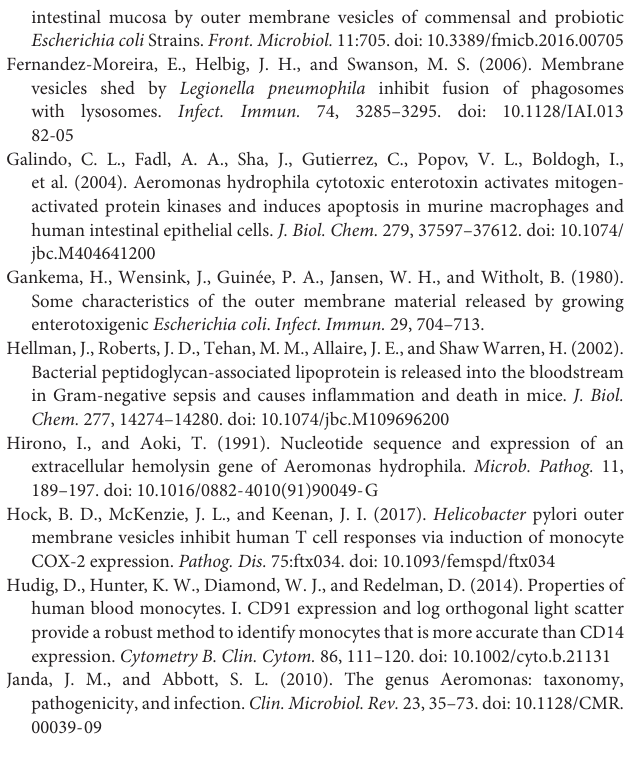
FIGURE S1 | Enrichment of function for proteins identified in Aeromonas hydrophila ATCC R (cid:13) 7966 TM OMVs. According to the COG annotation, proteins identified in OMVs (A) were grouped into (i) Information, storage and processing proteins (translation, ribosomal structure and biogenesis, RNA processing and modification, transcription, replication, recombination and repair, chromatin structure and dynamics), cellular processing and signaling proteins (cell cycle, cell division, chromosome portioning, defense mechanisms, signal transduction mechanism, cell wall/membrane/envelope biogenesis, cell motility, intracellular trafficking, secretion, and vesicular transport, posttranslational modification, protein turnover, chaperones), (ii) metabolisms proteins (energy production and conversion, carbohydrate transport and metabolism, amino acid transport and metabolism, nucleotide transport and metabolism, coenzyme transport and metabolism, lipid transport and metabolism, inorganic ion transport and metabolism, secondary metabolites biosynthesis, transport and catabolism), (iii) and poorly characterized proteins (general function prediction only, function unknown, not COG annotation). Clearly, a great variety of protein related-functions were enriched in OMVs compared with A. hydrophila genome (B) . FIGURE S2 | Effect on the actin rearrangement induced by A. hydrophila OMVs in PBMCs. Compared with the PHA control, OMVs from the A. hydrophila ATCC R (cid:13) 7966 TM does not induce deposition or depolimerization of actin-microfilaments. TABLE S1 | Proteins identified in OMVs from A. hydrophila